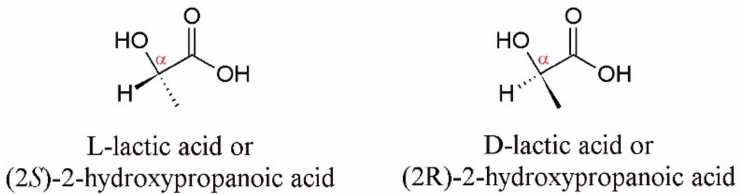
Figure 2. Lactic acid enantiomers. Common nomenclature and IUPAC nomenclature of the optical isomers of lactic acid. The α -carbon characteristic of α -hydroxycarboxylic acids is highlighted in